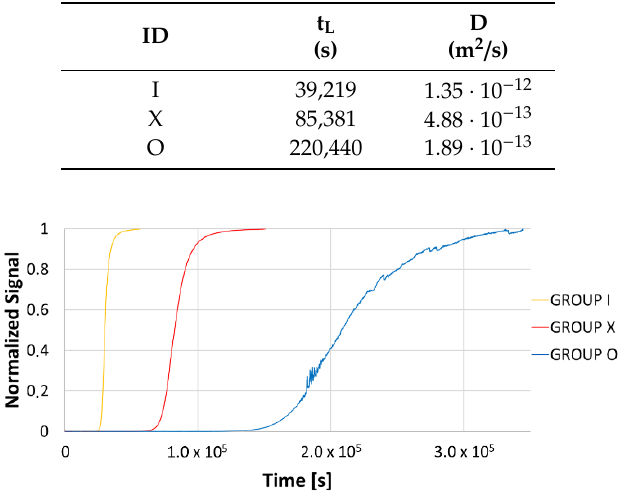
Table 3. Permeation test results for the steels under investigation.